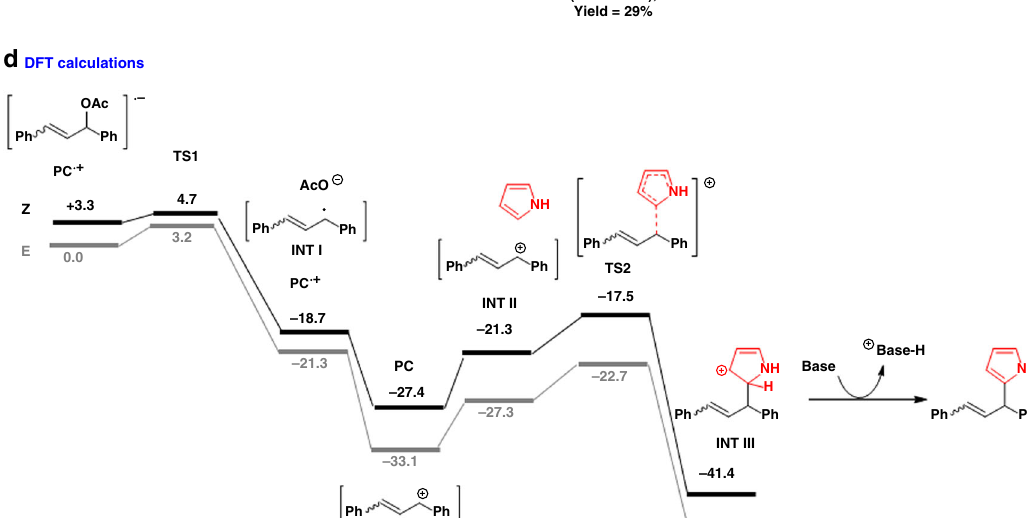
diffusion control rate (see Supplementary Information Fig. 9) gives rise to the contact radical ion pair at this singlet stage (Fig. 3a). All processes in the contact radical ion pairs undergo in the sub-nanosecond scale 46 . Fast acetate release from 1a · − led to INT I , which is still in close contact with 3g (cid:129) + . At this point, INT I undergoes an ultrafast back electron transfer with 3g (cid:129) + restoring 3g and generating INT II, whose amount is slightly dependent on the concentration of 1a in the sample (Fig. 4d). In addition, 3g (cid:129) + and INT I can split up, forming the corresponding free 3g (cid:129) + and free INT I , that are detected in the LFP experiments with lifetimes in the microsecond scale